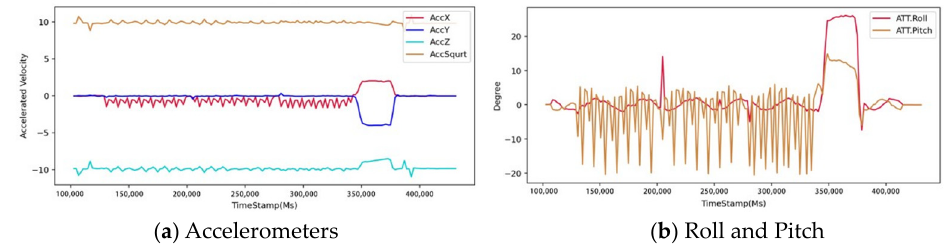
( a ) Accelerometers ( b ) Roll and Pitch Figure 16. UAV status changes when the remote controller fails. Figure 16. UAV status changes when the remote controller fails. Figure 16. UAV status changes when the remote controller